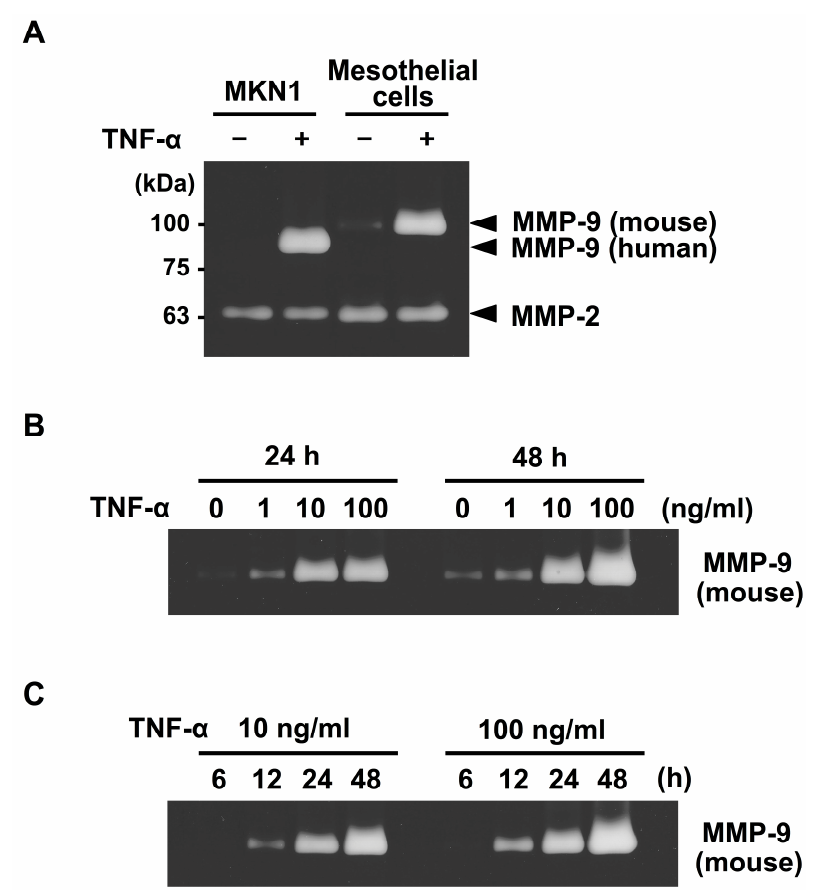
Figure 2. Effects of TNF-α on the secretion of MMP-9 from peritoneal mesothelial cells as assessed by zymography. ( A ) Monolayers of peritoneal mesothelial cells and MKN1 cells were separately cultured in ASF104 serum-free medium with/without TNF-α (10 ng/mL) for 48 h. ( B ) Mesothelial cells were cultured with TNF-α (0, 1, 10 or 100 ng/mL) for 24 or 48 h. ( C ) Mesothelial cells were cultured with TNF-α (10 or 100 ng/mL) for 6, 12, 24 or 48 h.